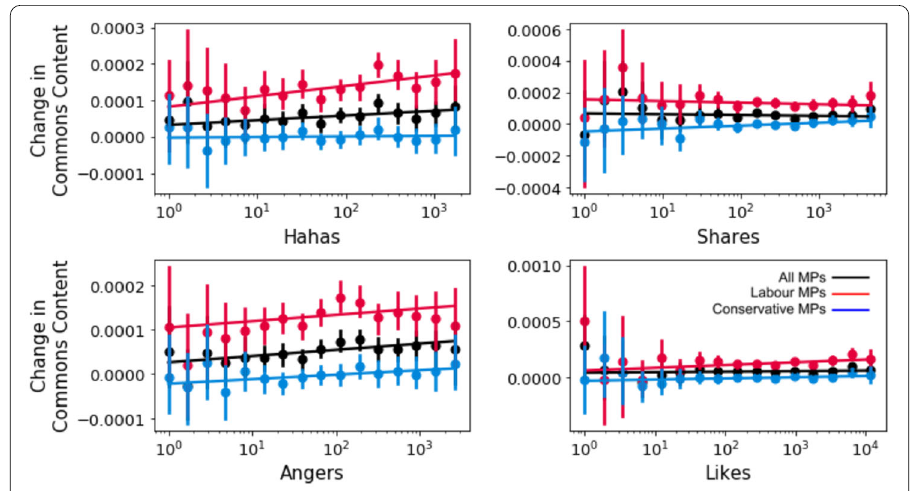
Figure 5 Word flow from Facebook to Commons speeches significantly increases with levels of Hahas. We show regression analyses of the marginal changes in content flow of Commons Speeches, associated with Facebook interactions. y-axis is content flow and x-axis is reaction count on a log scale. See Table 2 for p -values and slopes of significant